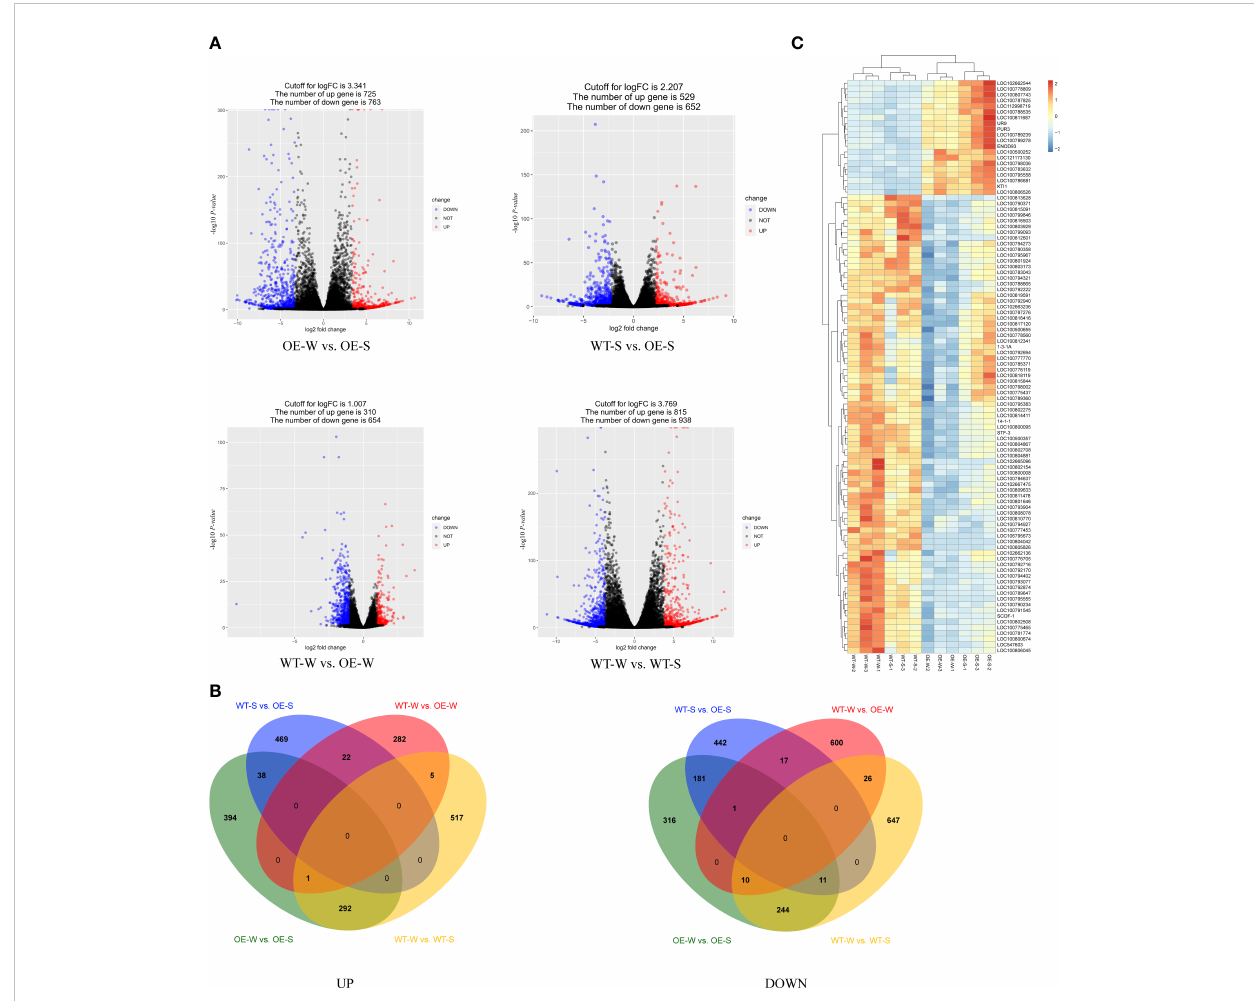
FIGURE 3 Transcriptome analysis. (A) Volcano plot. Red dots represent upregulated differentially expressed genes (DEGs), blue dots represent downregulated DEGs, and black dots represent fi ltered unigenes that are non-signi fi cantly regulated. (B) Comparison of DEGs among OE-W vs. OE-S, WT-S vs. OE-S, WT-W vs. OE-W and WT-W vs. WT-S. UP, up-regulated DEGs. DOWN, down-regulated DEGs. (C) Cluster analysis of DEGs under saline-alkali stress. The colors from red to blue indicate the highest to lowest log10(FPKM+1) values of each gene under saline-alkali stress or mock water